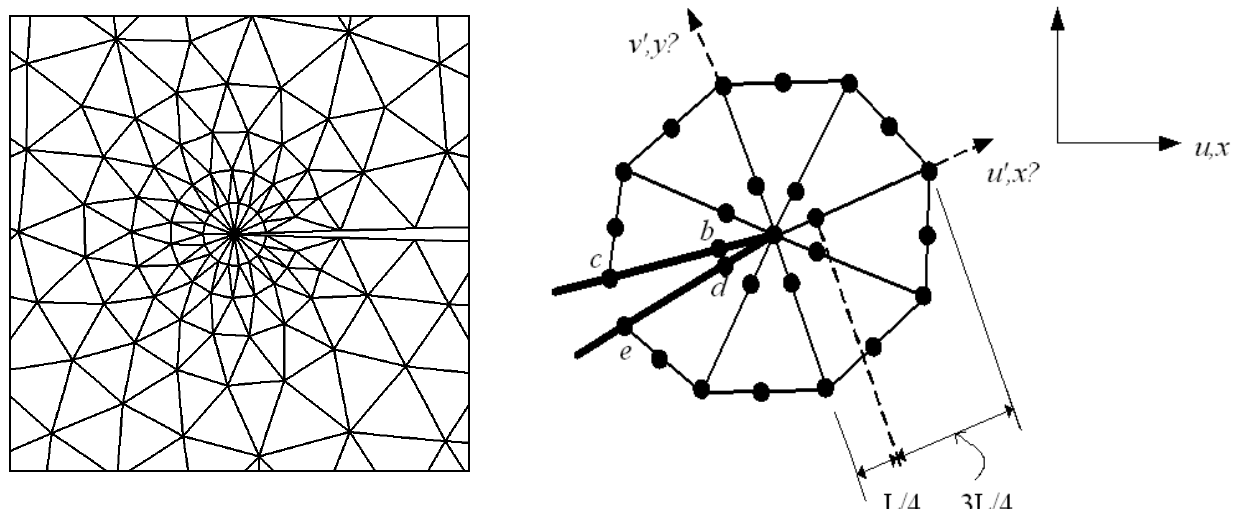
Figure 6. Triangular rosette elements and coordinates surrounding the crack tip.